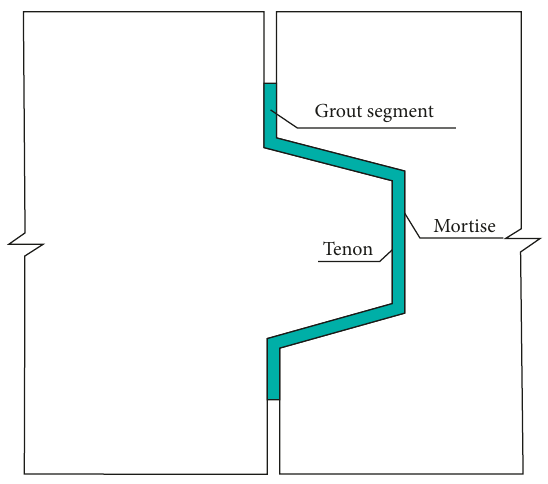
Figure 3: Grouted mortise and tenon